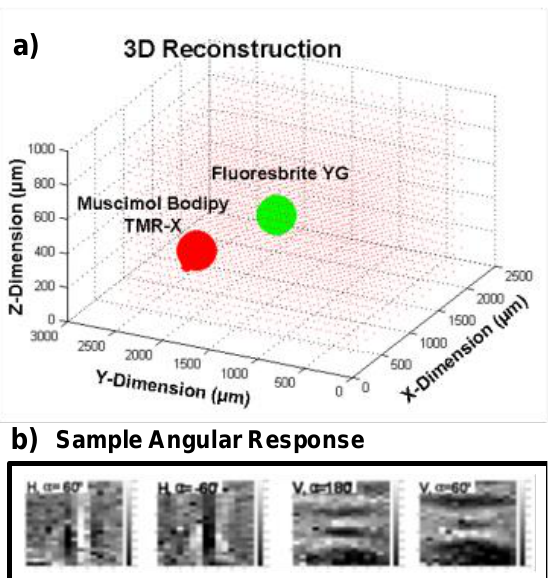
Figure 17. ( a ) 3D localization of two types of fluorophore micro-spheres. ( b ) Sample angular response from these